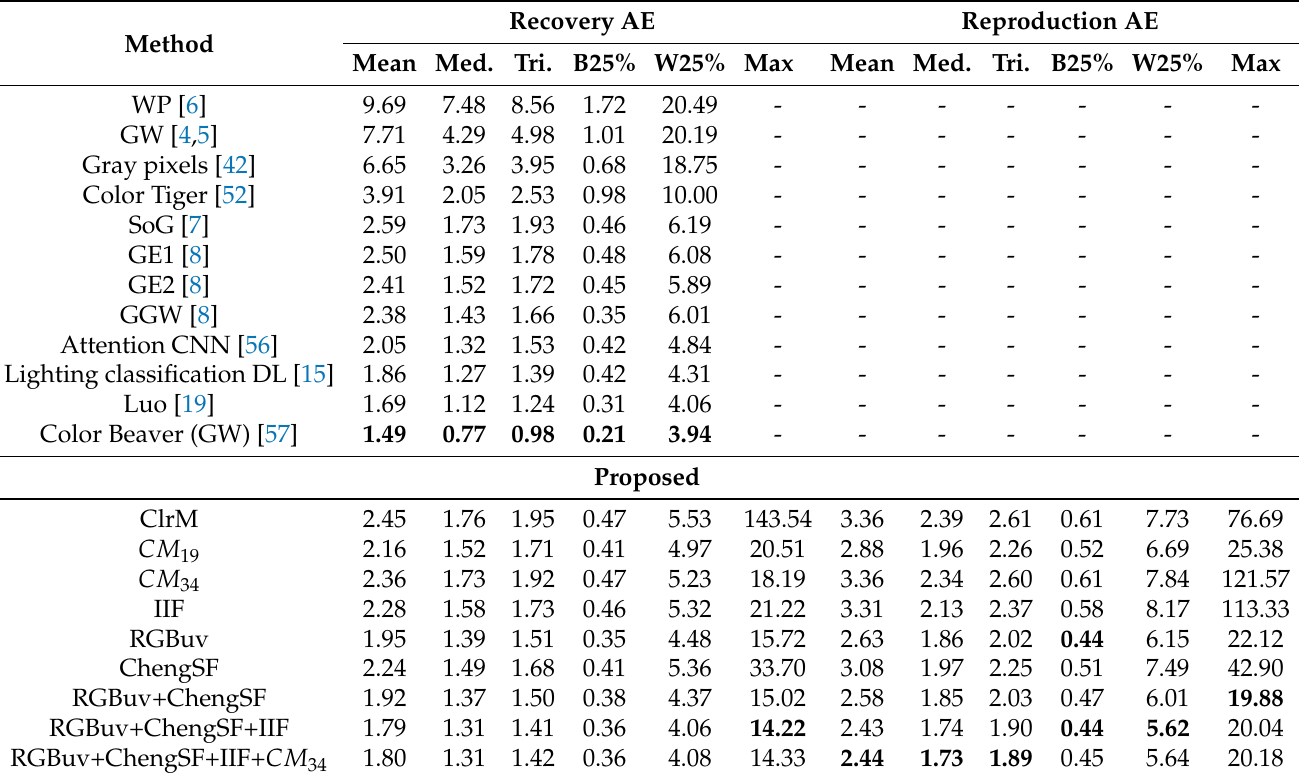
Table 2. Comparative performance metrics between our method and the previous methods on the Cube+ dataset. The statistical metrics of the previous methods are selected from